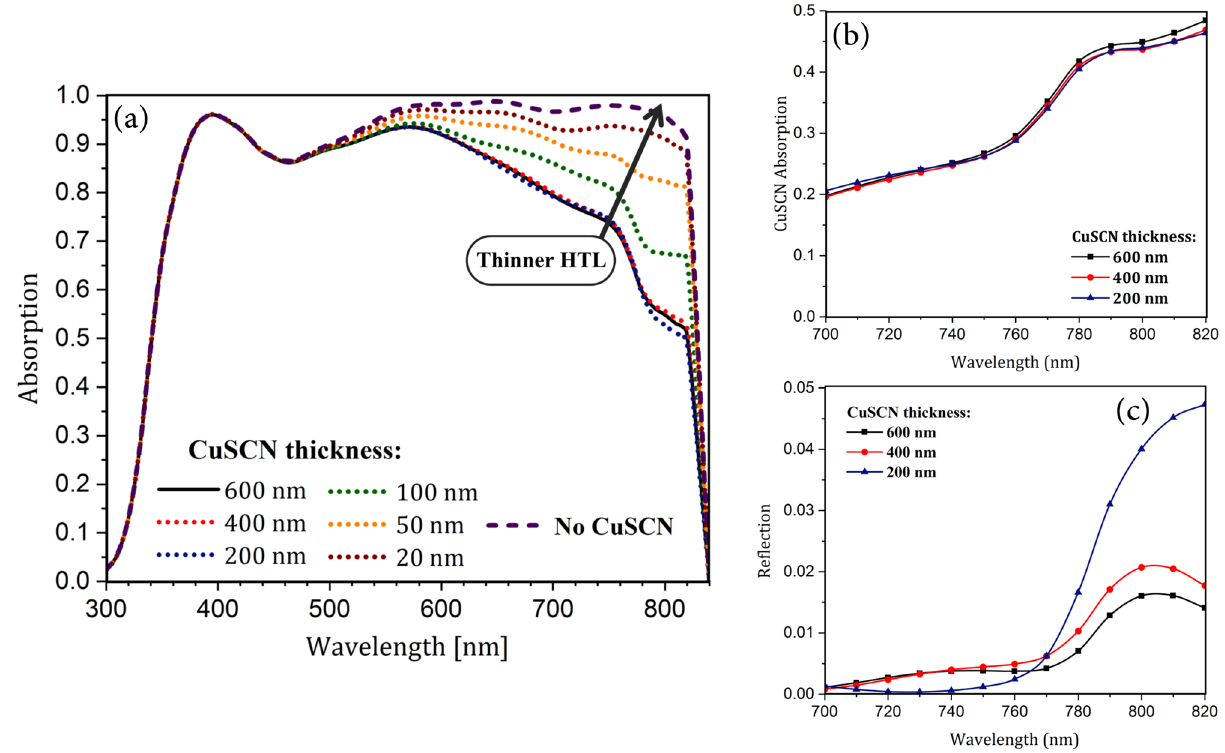
Fig. 7. Normalized absorption and reflection of the convex nanostructured PSC (structure (IV)) with different thicknesses of HTL. ( a ) Normalized perovskite absorption of Str (IV) with the HTL thicknesses of 600, 400, 200, 100, 50, and 20 nm. ( b ) Normalized CuSCN absorption, and ( c ) normalized reflection from Str (IV) with the HTL thicknesses of 600, 400, and 200